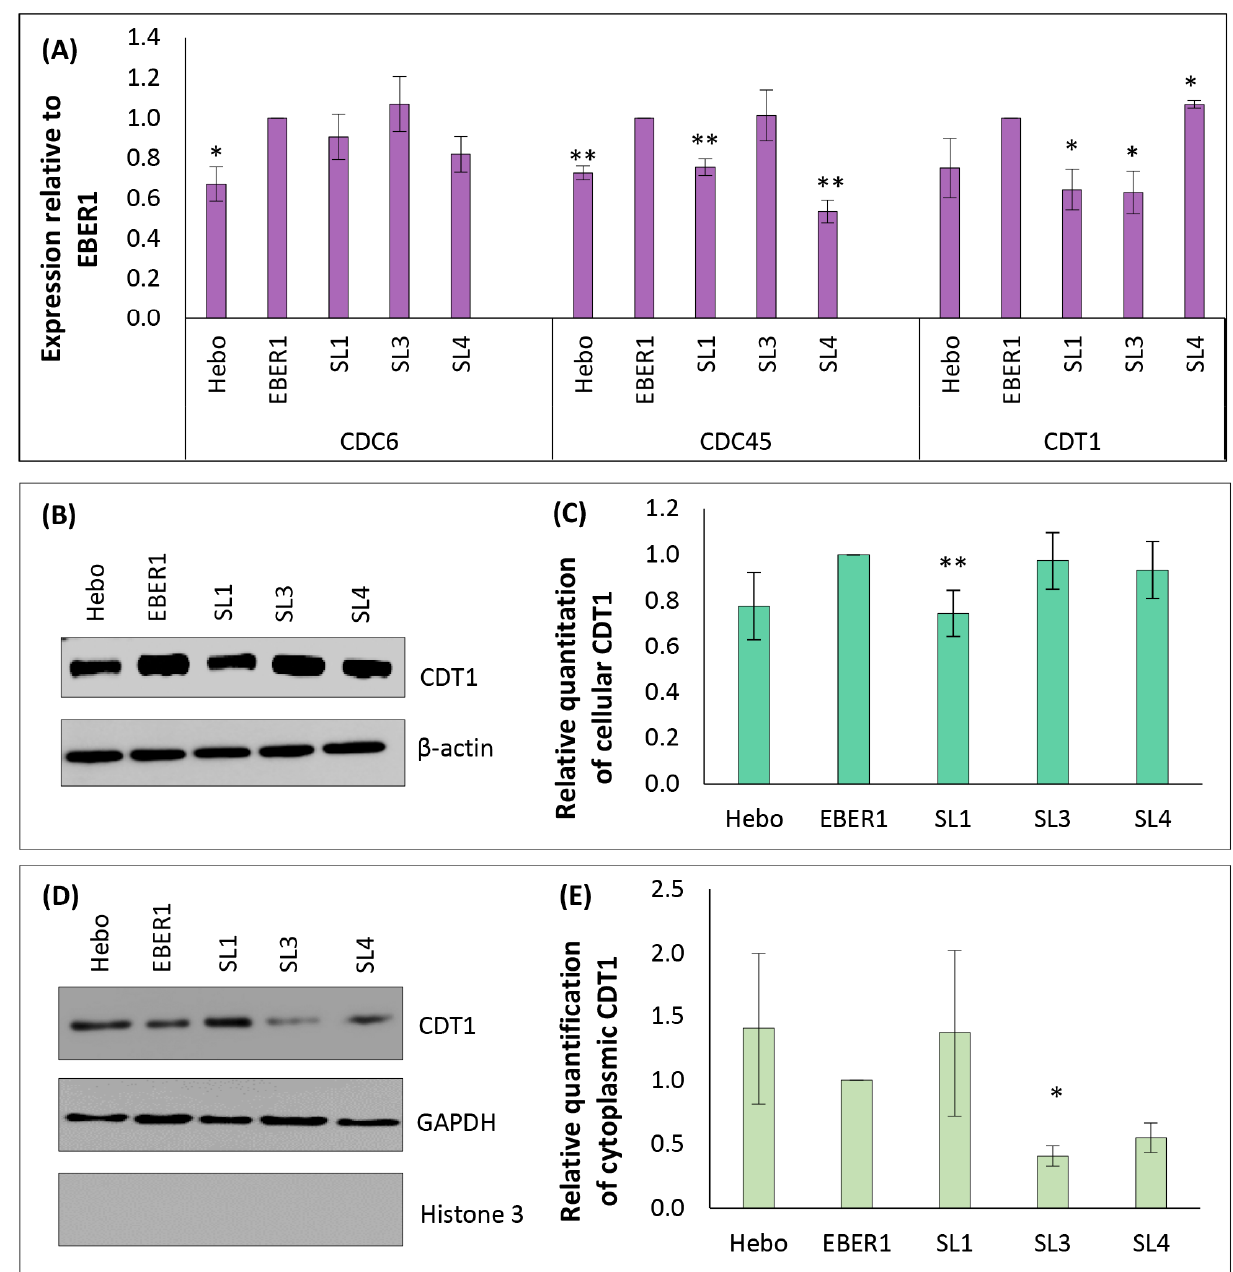
Figure 9. Expression of markers involved in cell cycle regulation in EBER1 transfectants . ( A ) qRT-PCR expression of regulatory genes necessary for firing an origin of replication (from the day 6 cells count). Expression of CDT1 protein from total cellular proteins obtained from the day 6 cell count was separated on an SDS-PAGE. ( B ) Western blot image from total cellular protein. ( C ) ImageJ quantification of total cellular CDT1 Western blot bands. ( D ) Western blot image of cytoplasmic CDT1. ( E ) Relative quantification of cytoplasmic CDT1 by qRT-PCR. Each experiment was performed in duplicate and repeated three times. Data were expressed as mean ( ± SEM) of the three independent experiments relative to EBER1 wildtype. * = p ≤ 0.05, ** = p ≤ 0.01.